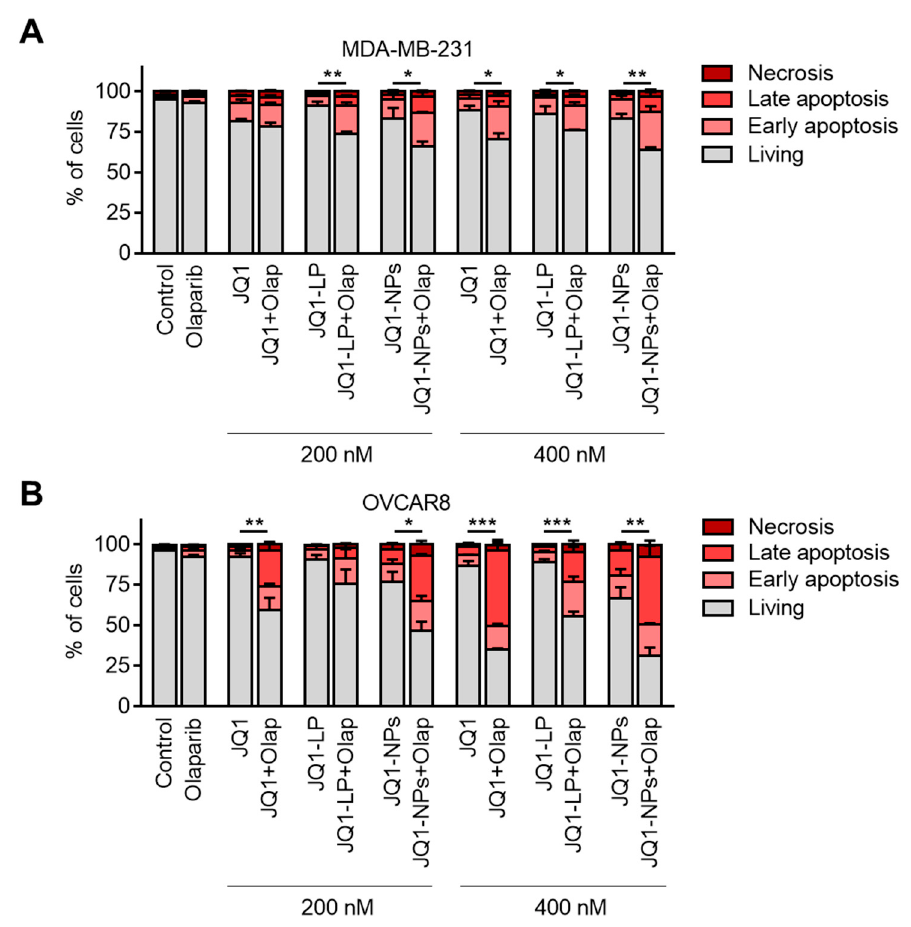
Figure 8. JQ1 free and JQ1 encapsulated forms synergize with olaparib. MDA-MB-231 breast cancer cells ( A ) and OVCAR8ovarian cancer cells ( B ) treated for 72 h with 200 or 400 nM of JQ1 (free), JQ1-LP and JQ1-NPs alone or in combination with olaparib (10 µ M). * p ≤ 0.05; ** p ≤ 0.01 and *** p ≤ 0.001.